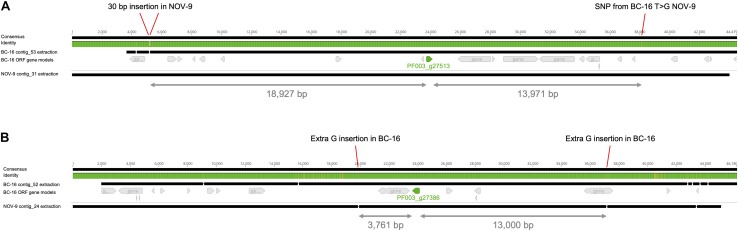
Differential expression of putative PfAvr2 and PfAvr3 is not due to sequence variation in Phytophthora fragariae BC-16 (UK2) and NOV-9 (UK3) genomes. Regions surrounding candidate avirulence genes, PfAvr2 and PfAvr3, from BC-16 and NOV-9 aligned with MAFFT in Geneious R10 (Katoh et al., 2002; Katoh and Standley, 2013). Black bars indicate contiguous sequences and gaps are represented by dashes. Identity is shown for all sequences in the alignment, green denotes residues at that position are the same across all sequences, yellow denotes less than complete identity and red denotes very low identity for the given position. (A) Putative PfAvr2, showing a 30 bp insertion in the NOV-9 sequence upstream of PF003_g27513 (shown in green) and a T to G SNP in NOV-9 downstream of the gene of interest. (B) Putative PfAvr3, showing an extra G insertion in BC-16 upstream of PF003_g27386 (an orthologue of PF009_g26267; shown in green) and an extra G insertion in BC-16 3,761 bp downstream.